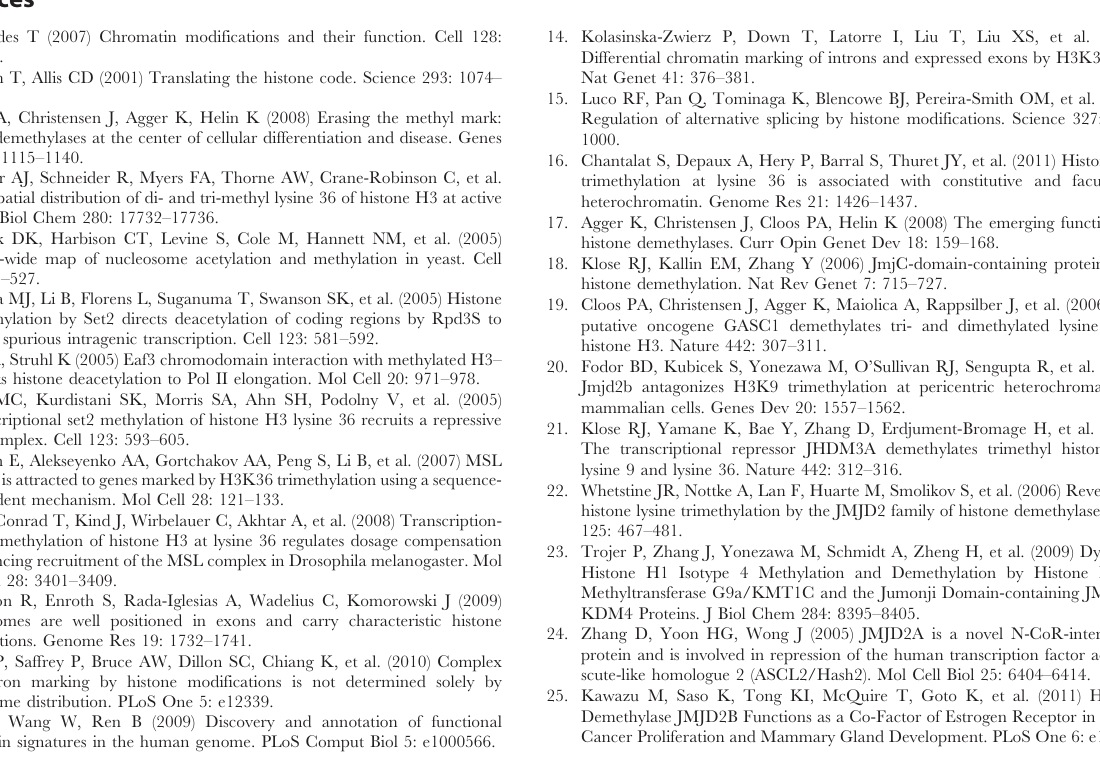
Figure S1 Reproducibility of H3K36me3 ChIP-chip. (A) Scatter plots showing correlation between probe values (log2 IP/ input) of replicate 1 versus replicate 2 for wild type (WT) and mutant profiles. The plots show strong correlation between two biological replicates. (B) The Venn diagram analysis of peaks called on wild type track of H3K36me3 ChIP-chip and peaks called using same criteria on H3K36me3 profile of 2–4 hr embryos of the Oregon R strain from modENCODE project. (TIF) Figure S2 The distribution of heterochromatic loci targeted by both HP1a and dKDM4A. The diagram illustrating the overall distribution of peaks of HP1a enrichment in wild type embryos and increased levels of H3K36me3 in dkdm4a mutant embryos at heterochromatin. Peaks overlap a gene more than 50% are in the category of ‘‘gene body’’, while peaks overlap a gene less than 50% are in the category of ‘‘gene-overlapping.’’ TSS, transcription start site; TES, transcription end site.